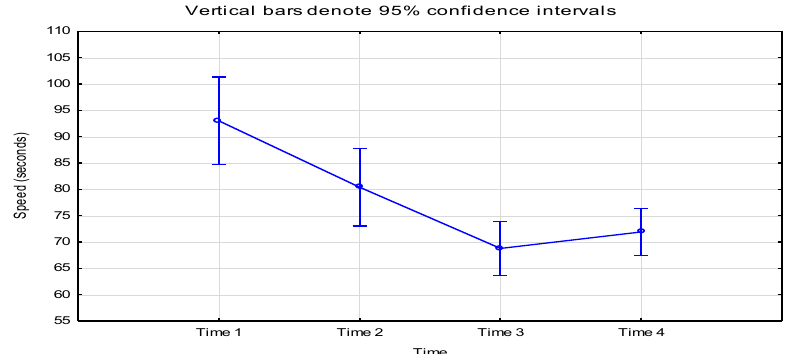
Means plot for average time per envelope processed Vertical bars denote 95% confidence